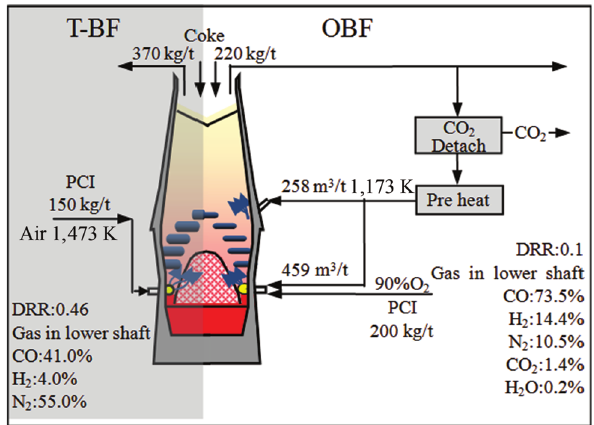
Figure 1: The process flows of T-BF and OBF [7, 11].